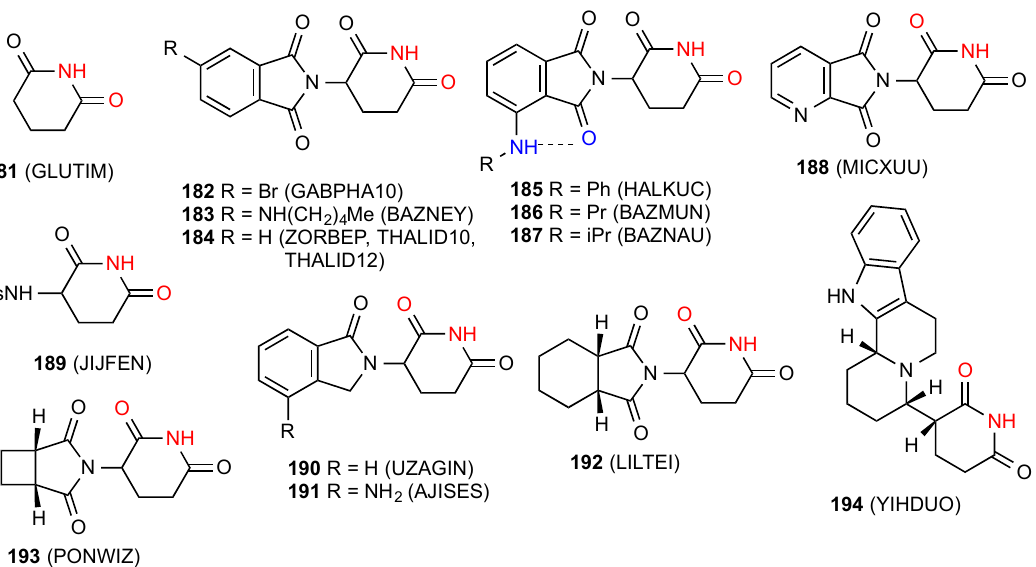
Figure 57. Glutarimide (pattern B ) and 3-monosubstituted glutarimides with pattern A structures.